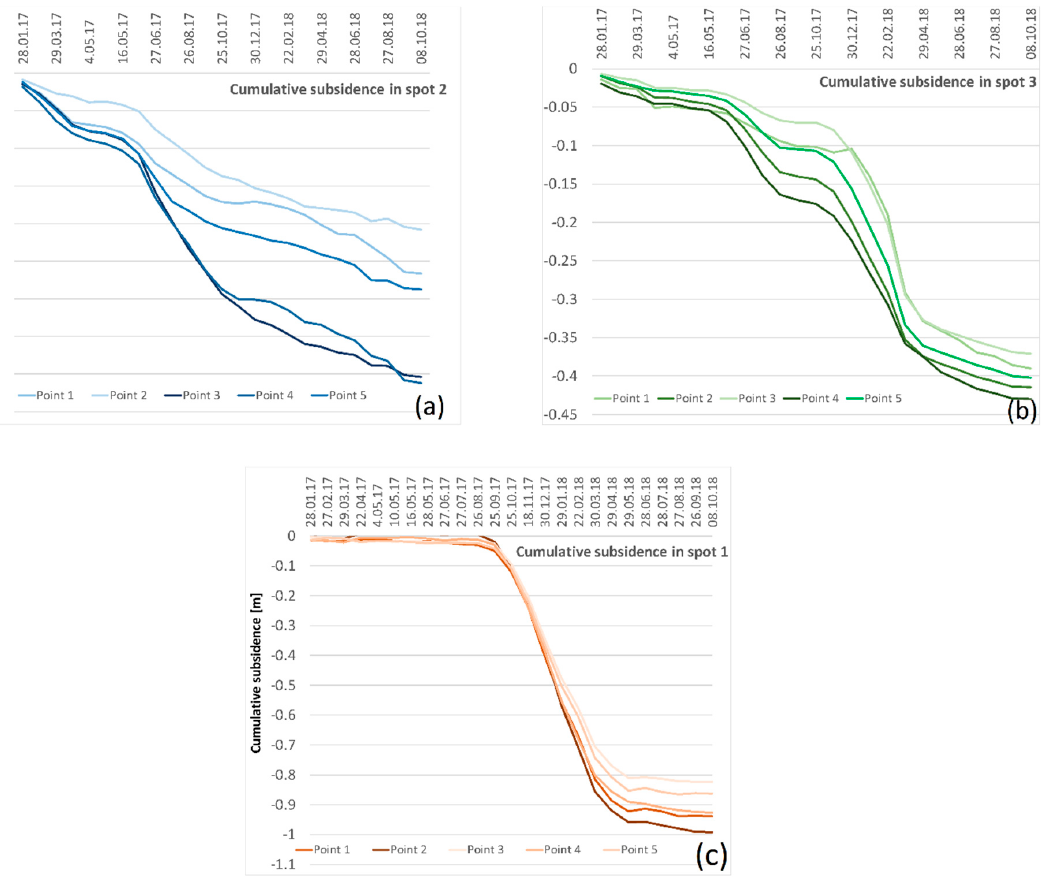
Figure 9. Deformation time series for selected points in the deformation spot: no. 1 ( a ), 2 ( b ), and 3 ( c ).